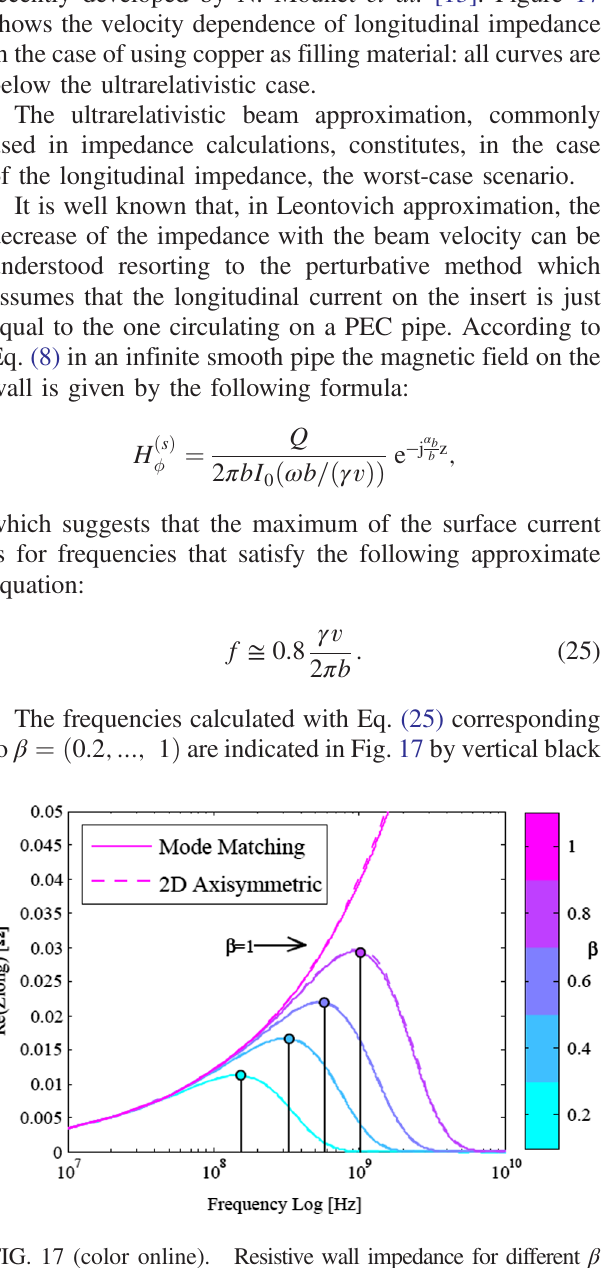
FIG. 17 (color online). Resistive wall impedance for different β (0.2, ...,1). Insert with σ ¼ 100 S=m , b ¼ 5 cm, t ¼ 15 cm, L ¼ 2 mm.